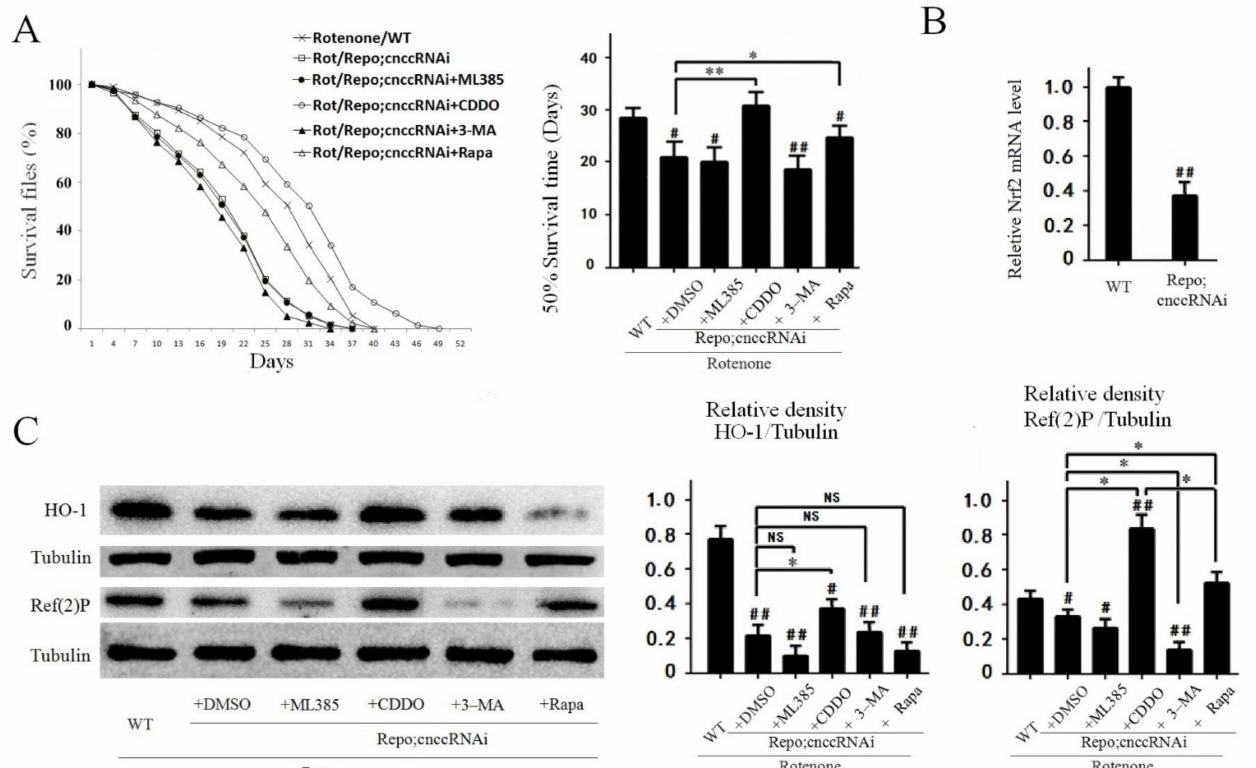
Figure 6. Knockdown of Nrf2 in fly glial cells worsens rotenone-induced PD-like phenotypes in flies. ( A ) The survival curve in Nrf2-knockdown Drosophila. The graph shows the survival curve, the Log-rank test, and half survival time used to analyze the difference between groups ( # , compared with the rotenone/WT group). Nrf2 knockdown in glial cells reduced survival time in the Rot/Repo;cnccRNAi + DMSO group compared with the rotenone/WT group ( # p < 0.05). CDDO-Me significantly extended survival time in the Rot/Repo;cnccRNAi + CDDO-Me group compared with the Rot/Repo;cnccRNAi + DMSO group (** p < 0.01). Rapamycin partially restored the shortened survival time of the Rot/Repo;cnccRNAi + DMSO group (* p < 0.05). ( B ) qRT-PCR result for drosophila Nrf2, the cncc level in Repo;cnccRNAi flies was about 40% compared with WT Control ( ## p < 0.01). ( C ) Western blot analysis of antioxidant and autophagy proteins in fly brain. Nrf2 knockdown in glial cells by RNAi significantly decreased protein expression of HO-1 and Ref(2)P in the rotenone/Repo;cnccRNAi group compared with the rotenone/WT group ( # p < 0.05 and ## p < 0.01). CDDO-Me partially restored this decrease in HO-1 and Ref(2)P expression in the rotenone/Repo;cnccRNAi + CDDO-Me group compared with the rotenone/Repo;cnccRNAi + DMSO group (* p < 0.05). Rapamycin partially restored the expression of the Ref(2)P autophagy protein, but did not alter HO-1 levels in the rotenone/Repo;cnccRNAi + Rapa group compared with the rotenone/Repo;cnccRNAi + DMSO group (* p <